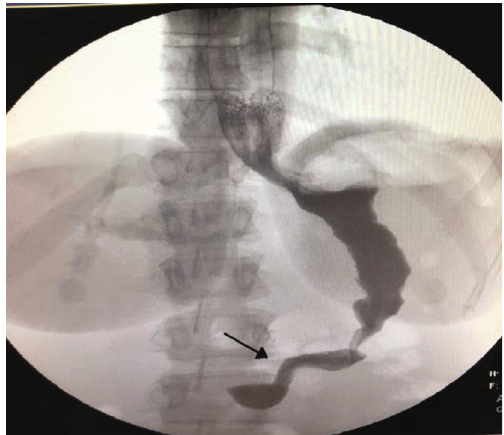
Figure 2: Postoperative gastrogra fi n swallow study showed contrast is passing through the duodenum into small loops. No gastroesophageal re fl ux was seen on fl uoroscopy.